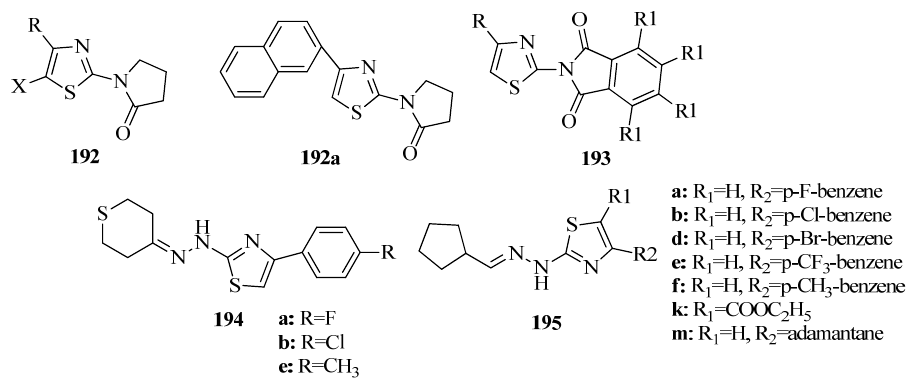
Figure 73. Structures of 2,4,5-trisubstituted thiazoles ( 192 ), 2-(thiazol-2-yl)isoindoline-1,3-diones( 193 ) and 2-(cyclopentylmethylene)hydrazinyl-1,3-thiazoles.